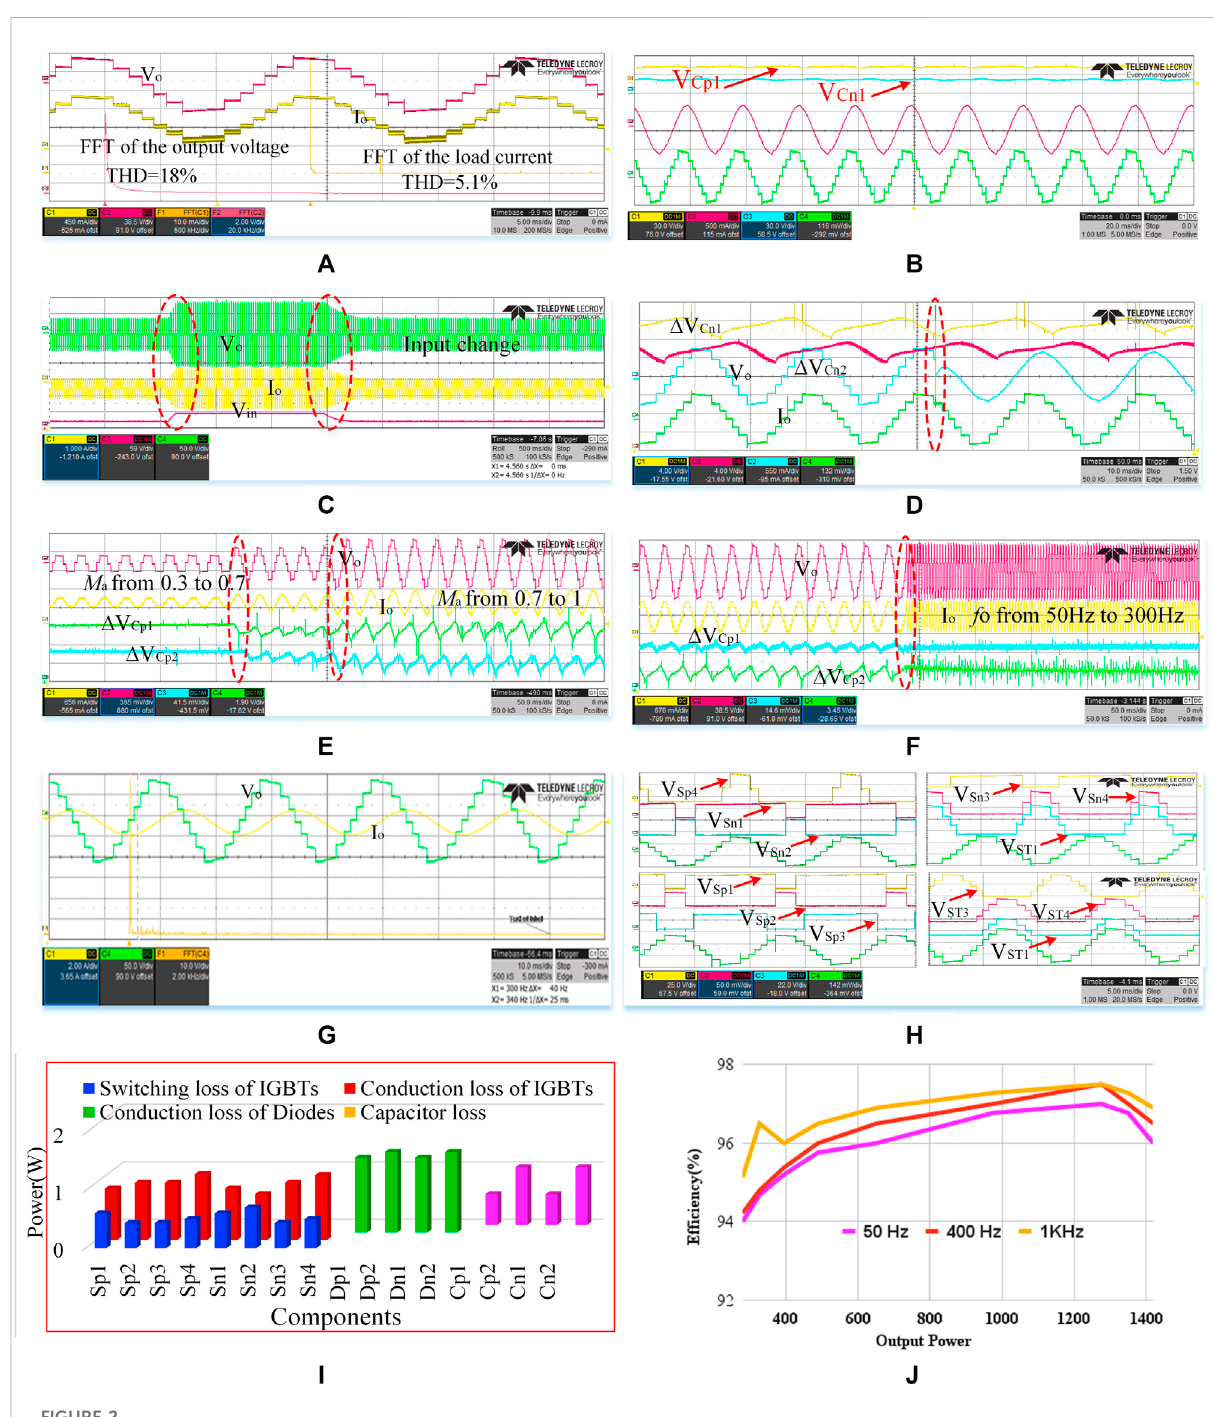
FIGURE 2 Experimental validation and power-loss analysis of the proposed